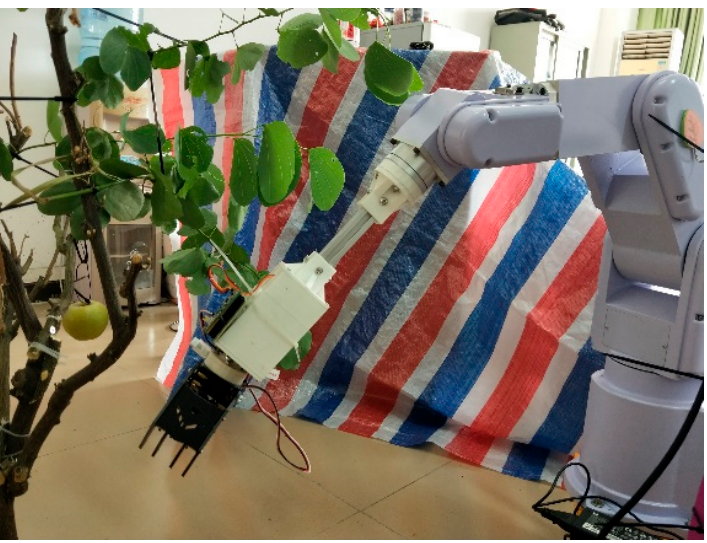
Figure 14. Picking experimental scene.